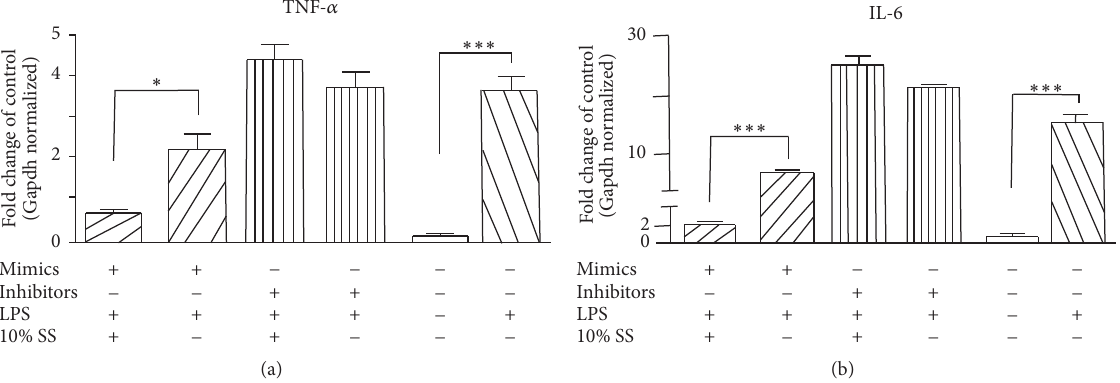
Figure 6: The combination effect of miR-152-3p and mimics (inhibitor) on TNF- 𝛼 and IL-6 expression. (a) The change of TNF- 𝛼 mRNA expression under various conditions. (b) The change of IL-6 mRNA expression under various conditions. ∗ 𝑃 < 0.05 ; ∗∗∗ 𝑃 < 0.001 between two groups